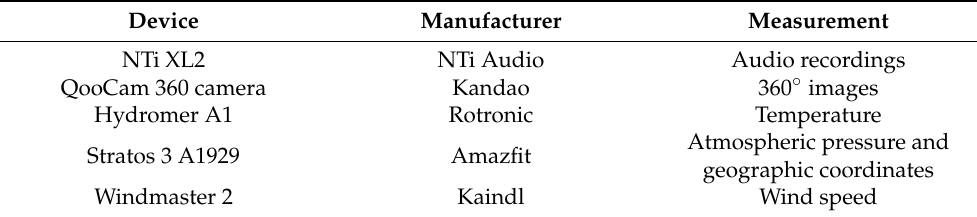
Table 1. Devices used in the study for field